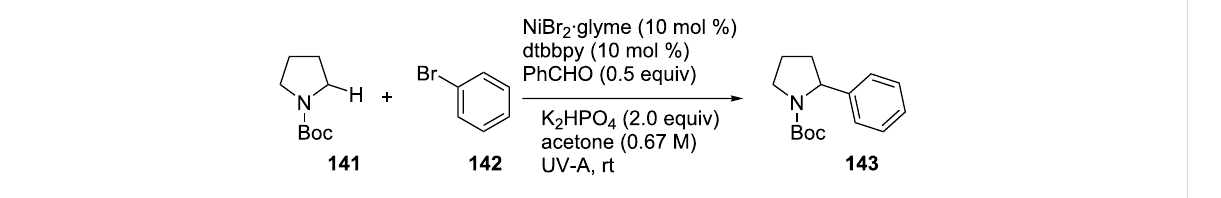
Scheme 31: C(sp 3 )–H Functionalization of N-containing molecules.